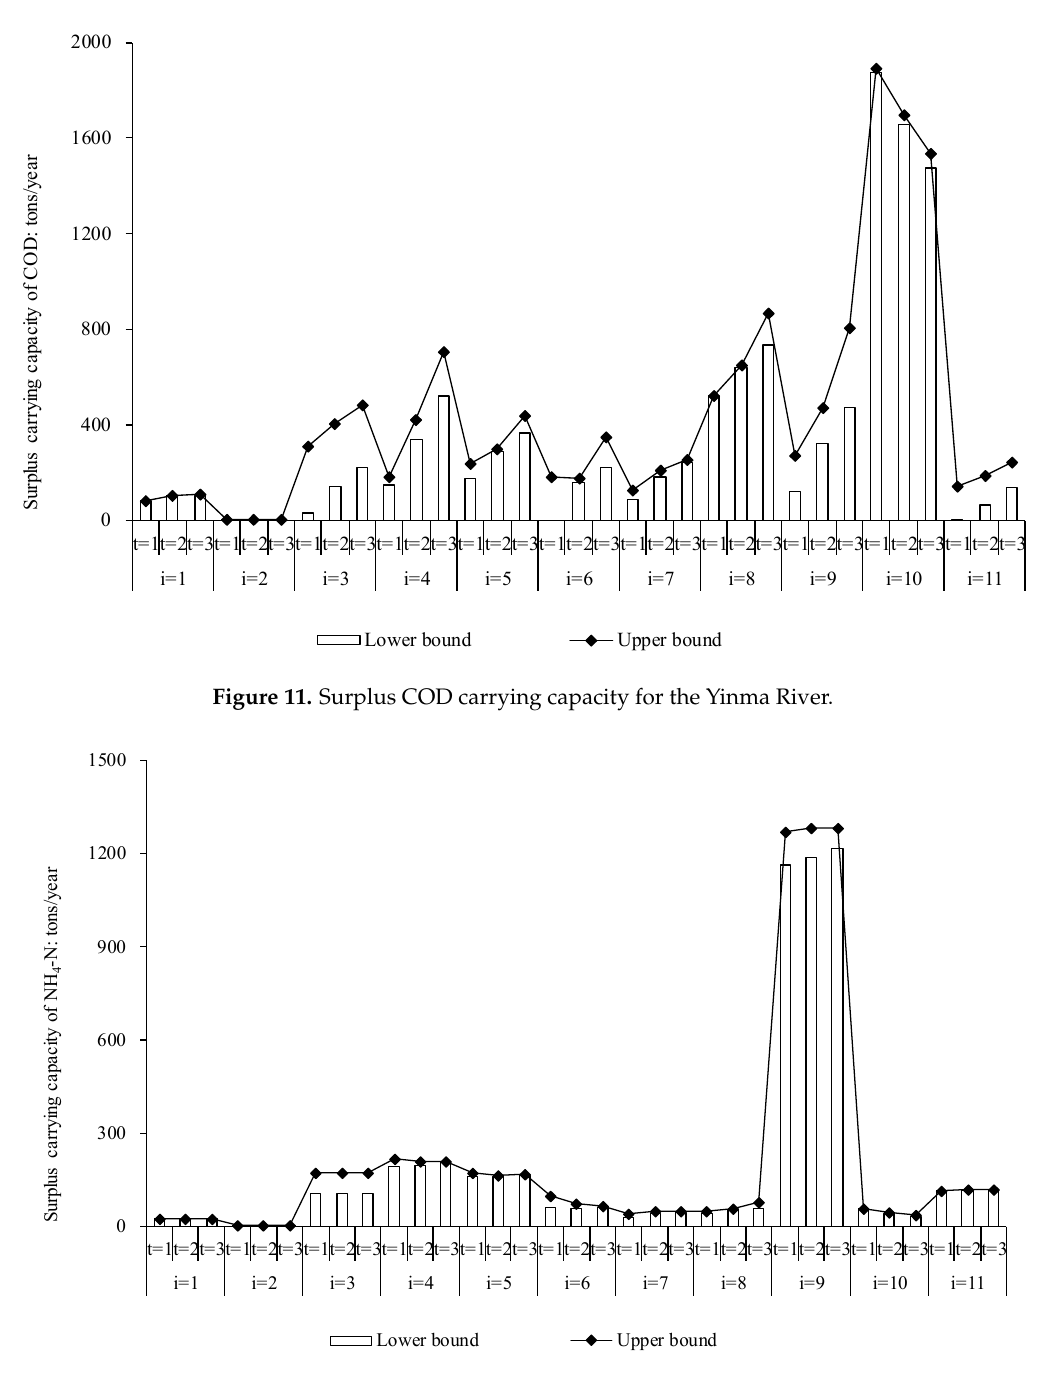
Figure 12. Surplus NH 4 -N carrying capacity for the Yinma River. Table 7. Projects for improving the water environment carrying capacity in the Yinma River.